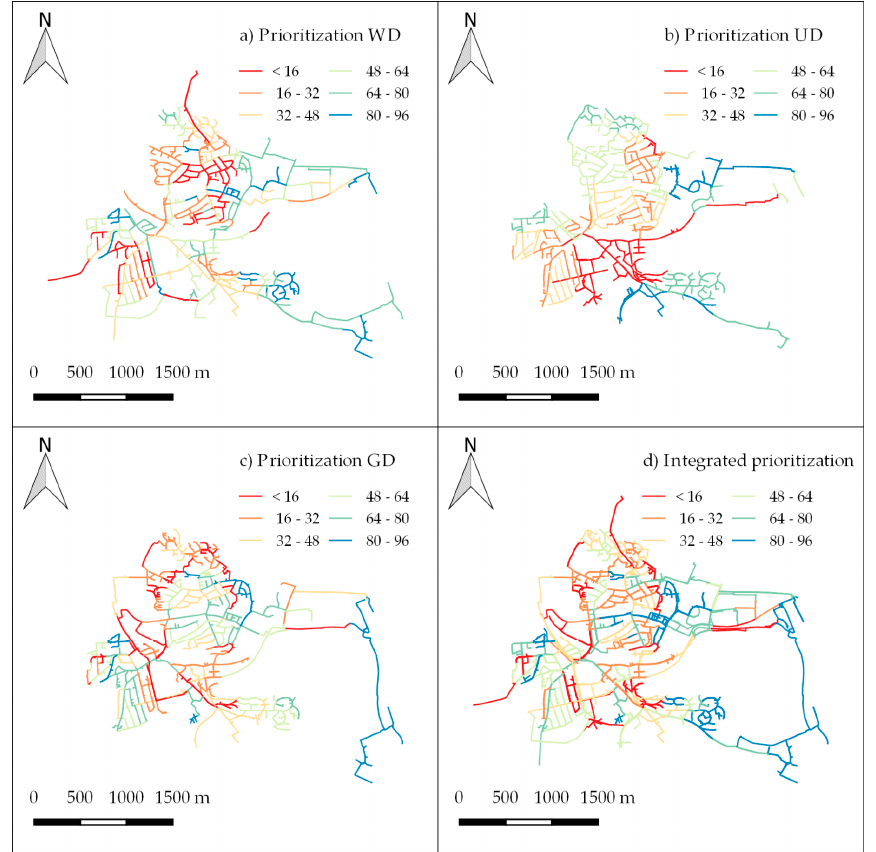
Figure 5. Result of the prioritization using the AHP method for: ( a ) the water distribution (WD) network; ( b ) the urban drainage (UD) network; ( c ) the gas distribution (GD) network; and ( d ) the integrated prioritization including the three networks and the road condition.